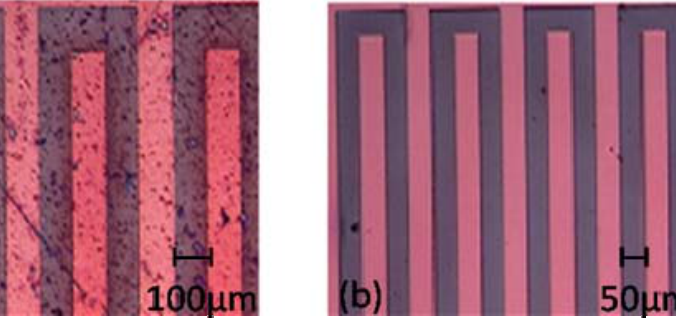
Figure 4. Optical microscopic images representative of the grading scale used in Table 1. (a) ‘worst effect’ (grading scale ---) and (b) ‘no effect’ (grading scale